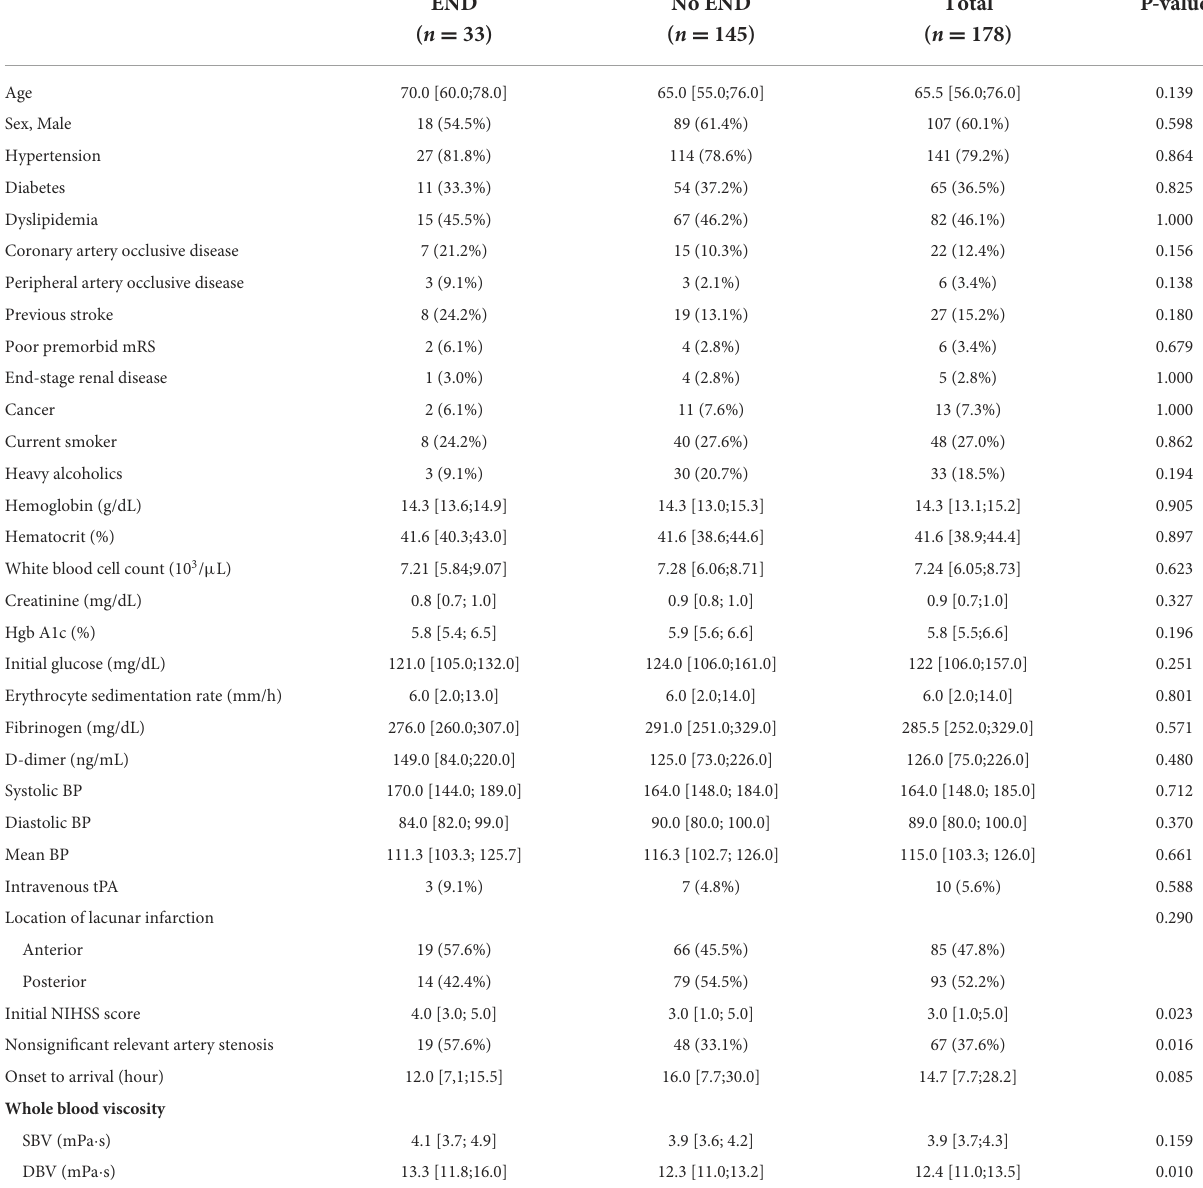
TABLE 1 Comparison of baseline characteristics on the presence of early neurologic